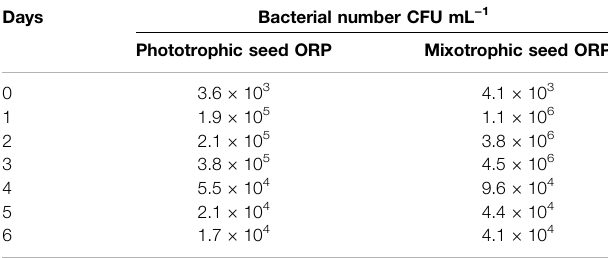
TABLE 2 | Bacterial count in outdoor